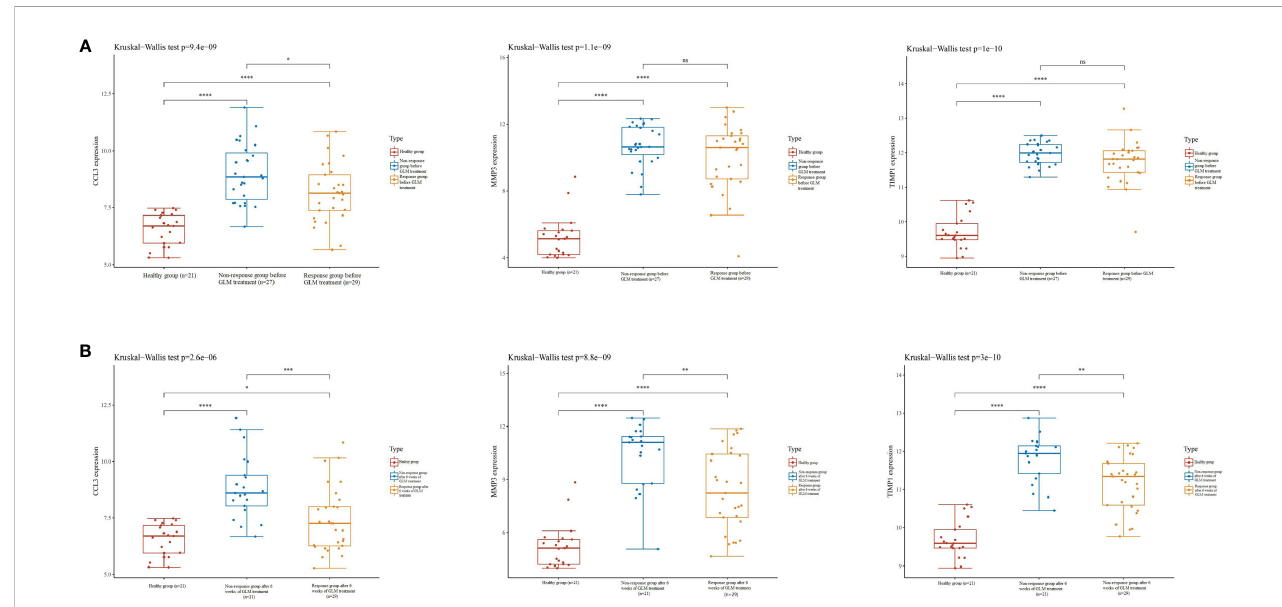
FIGURE 7 Expression of CCL3, MMP3, and TIMP1 on GLM in patients with UC. (A) Expression of CCL3, MMP3, and TIMP1 in the intestinal mucosa of patients with active UC in the non-response and response groups before GLM treatment. (B) Expression of CCL3, MMP3, and TIMP1 in the intestinal mucosa of patients with active UC after 6 weeks of GLM treatment in the response and non-response